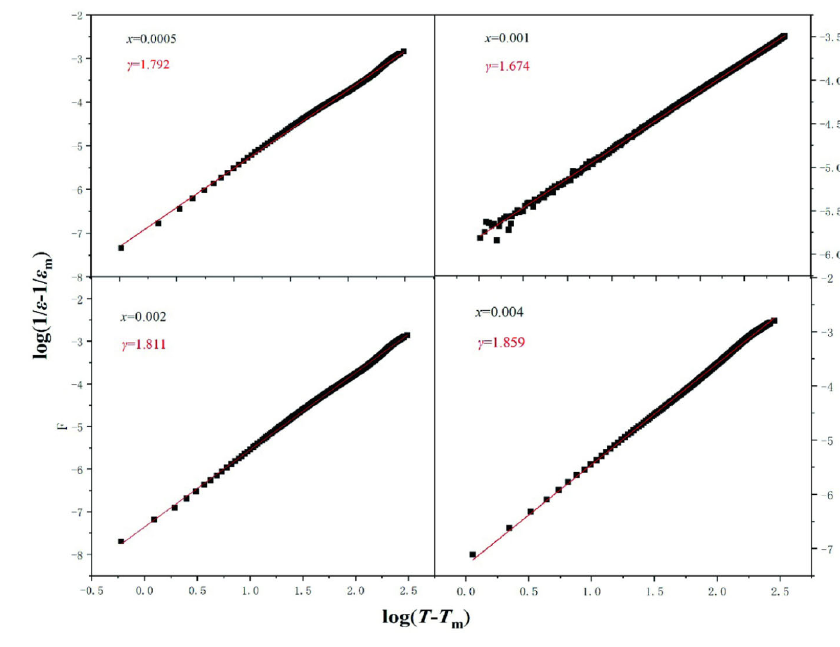
Fig. 9 Plot of log(1/ ε –1/ ε m ) as a function of log( T – T m ) for the KNNS–0.04BNKZ– x Sm ( x = 0.0005, 0.001, 0.002, and 0.004) ceramics at 10 kHz.